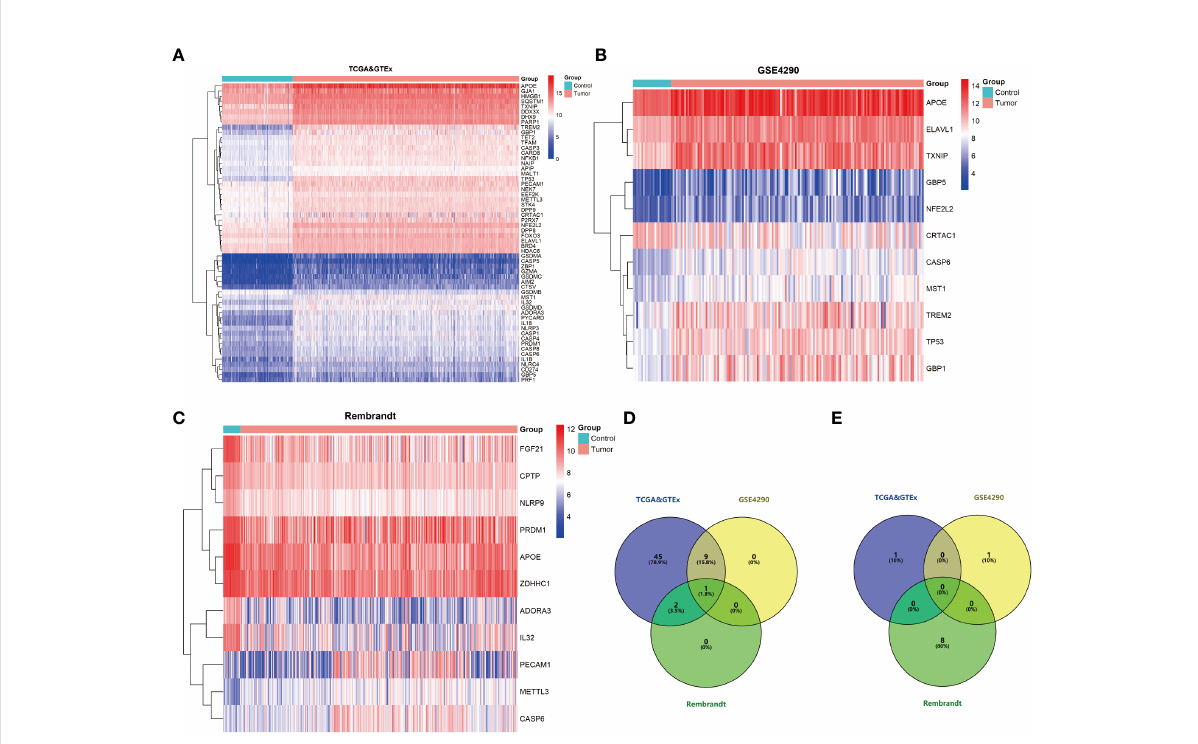
FIGURE 1 Pyroptosis-related differential expressed genes (PRDEGs) in glioma. (A) Heatmap of PRDEGs in the TCGA & GTEx datasets. (B) Heatmap of PRDEGs in the GSE4290 dataset. (C) Heatmap of PRDEGs in the REMBRANDT database. (D) Venn diagrams of up-regulated PRDEGs. (E) Venn diagrams of down-regulated